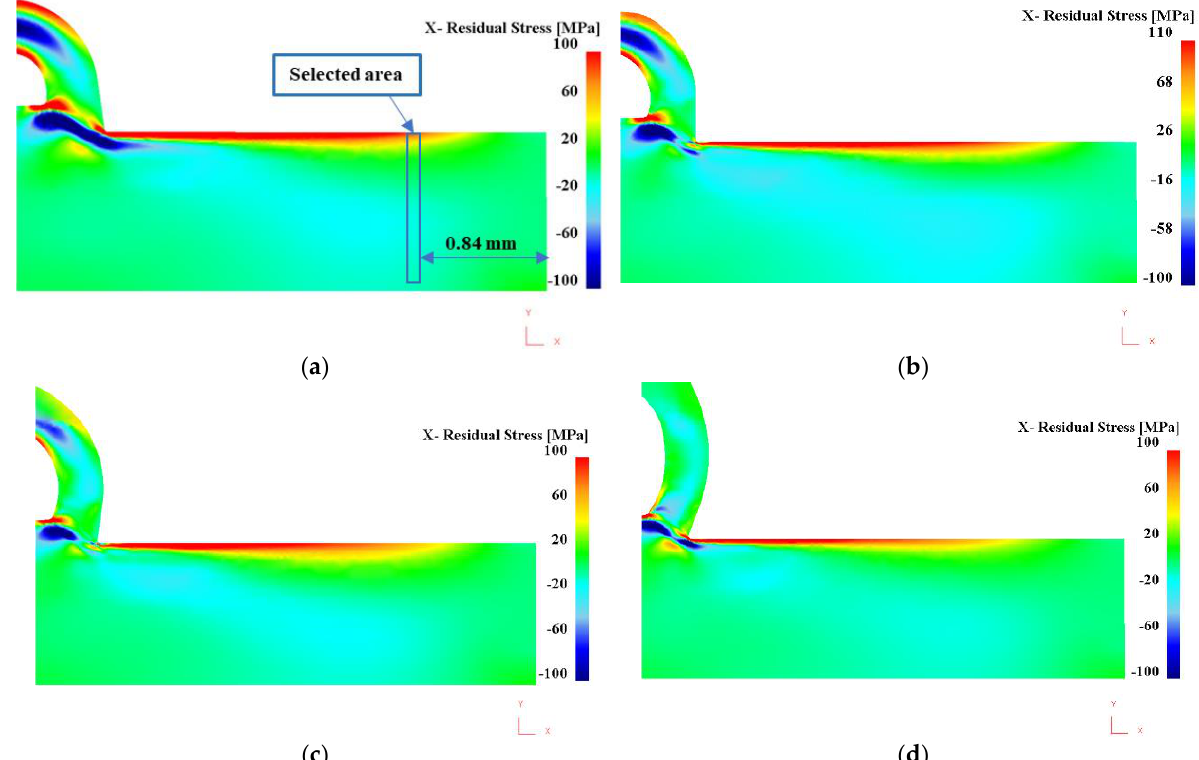
Figure 16. Simulation results of residual stresses along the workpiece’s depth (α = 7° and 𝑟 𝜀 = 20 µm): ( a ) −8°, ( b ) 0°, ( c ) 17.5°, and ( d ) 20°.